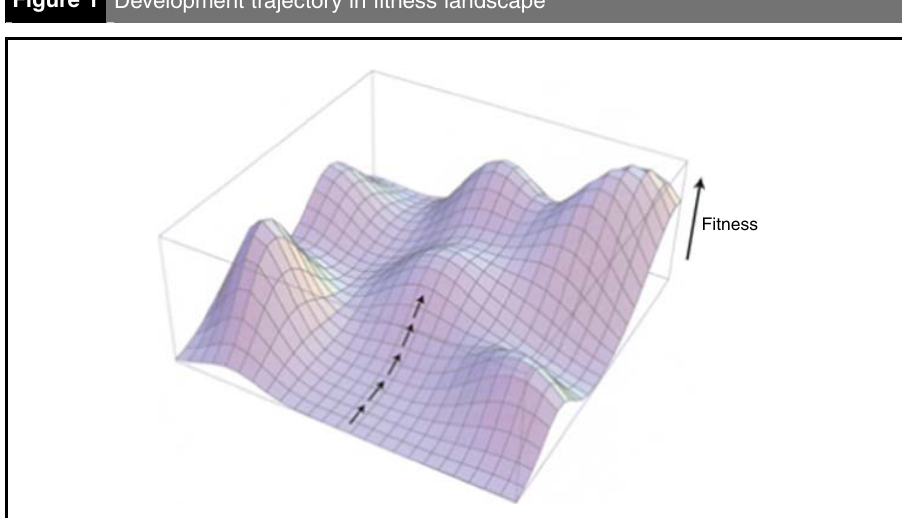
Source: Barton et al.